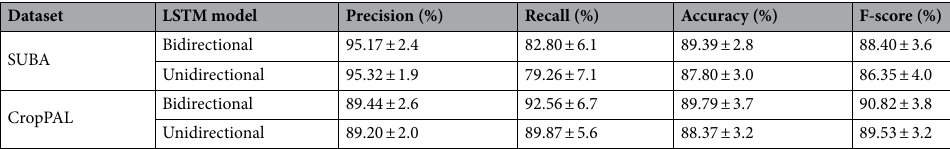
Table 1. Mean and standard deviation of the precision, recall, accuracy and F1-score for the tested uni- and bi-directional LSTM models on the SUBA and CropPAL datasets.